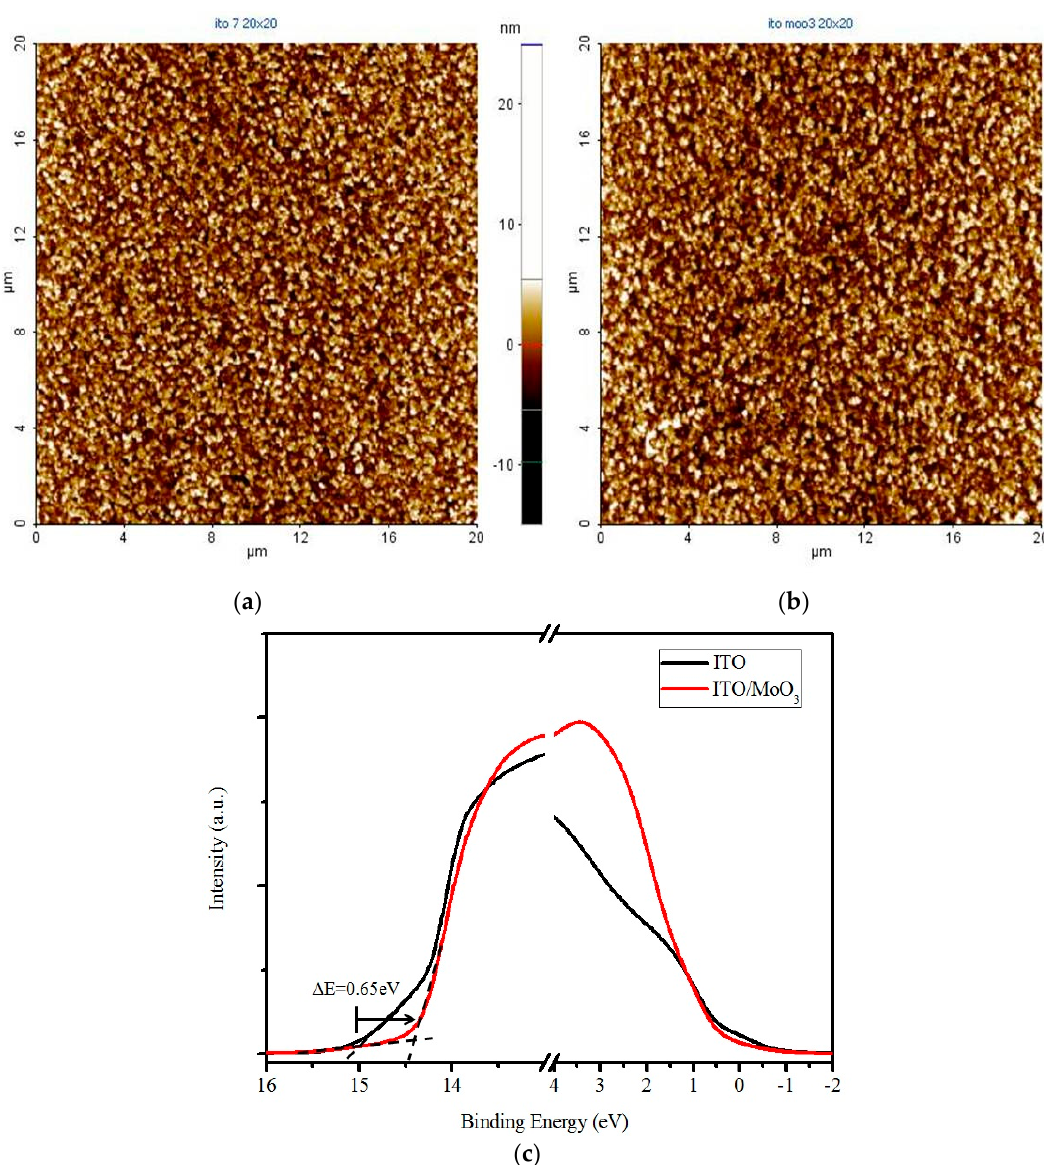
Figure 5. The result of surface roughness: ( a ) The device with the anode buffer layer; ( b ) The device without the anode buffer layer; ( c ) The ultraviolet photoelectron spectroscopy (UPS) spectrum of indium tin oxide (ITO) and ITO/MoO 3 . Table 1. The photovoltaic performance of bilayer organic solar cells (OSCs) (Donor/C 60 ) is sorted and estimated the properties of devices with structure: ITO/MoO 3 (10 nm)/Donor/C60 (30 nm)/Bathocuproine (BCP) (10 nm)/Ag (100 nm). Material Thickness